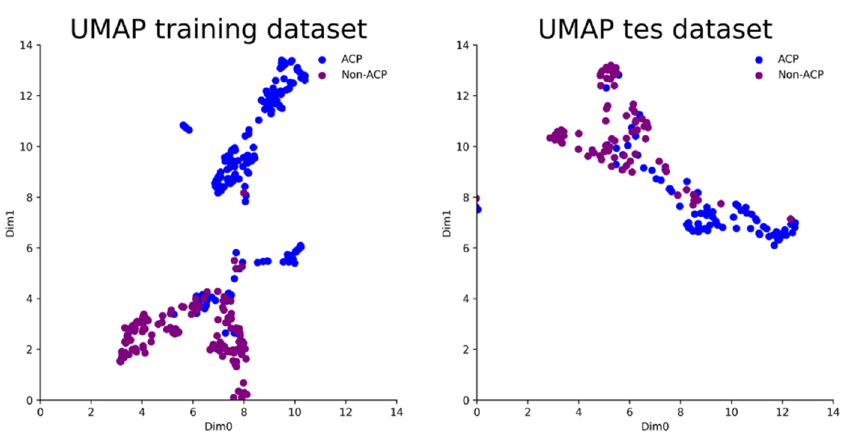
Figure 4. The importance rank of manually selected features.